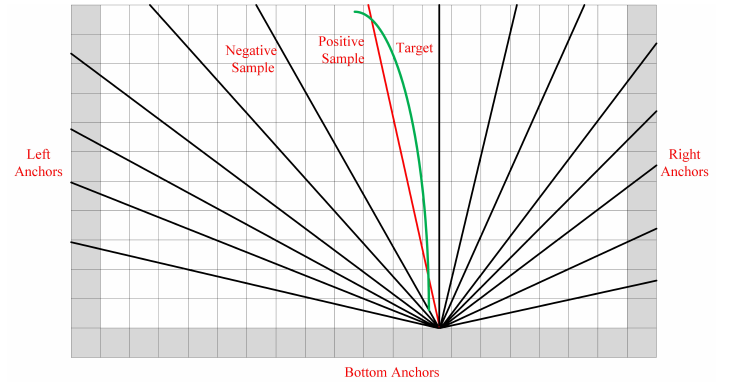
Figure 4. The illustration of anchor line generation process. The green line is the target lane. The red line is the anchor line closest to the target, which is treated as the positive sample. The black lines are negative samples. The gray grids are the starting coordinates for generating the anchor line, including left anchors, bottom anchors, and right